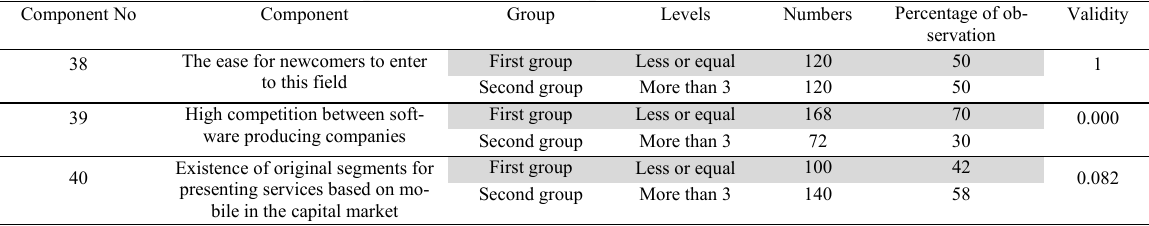
Statistical indicators for the competitive market components